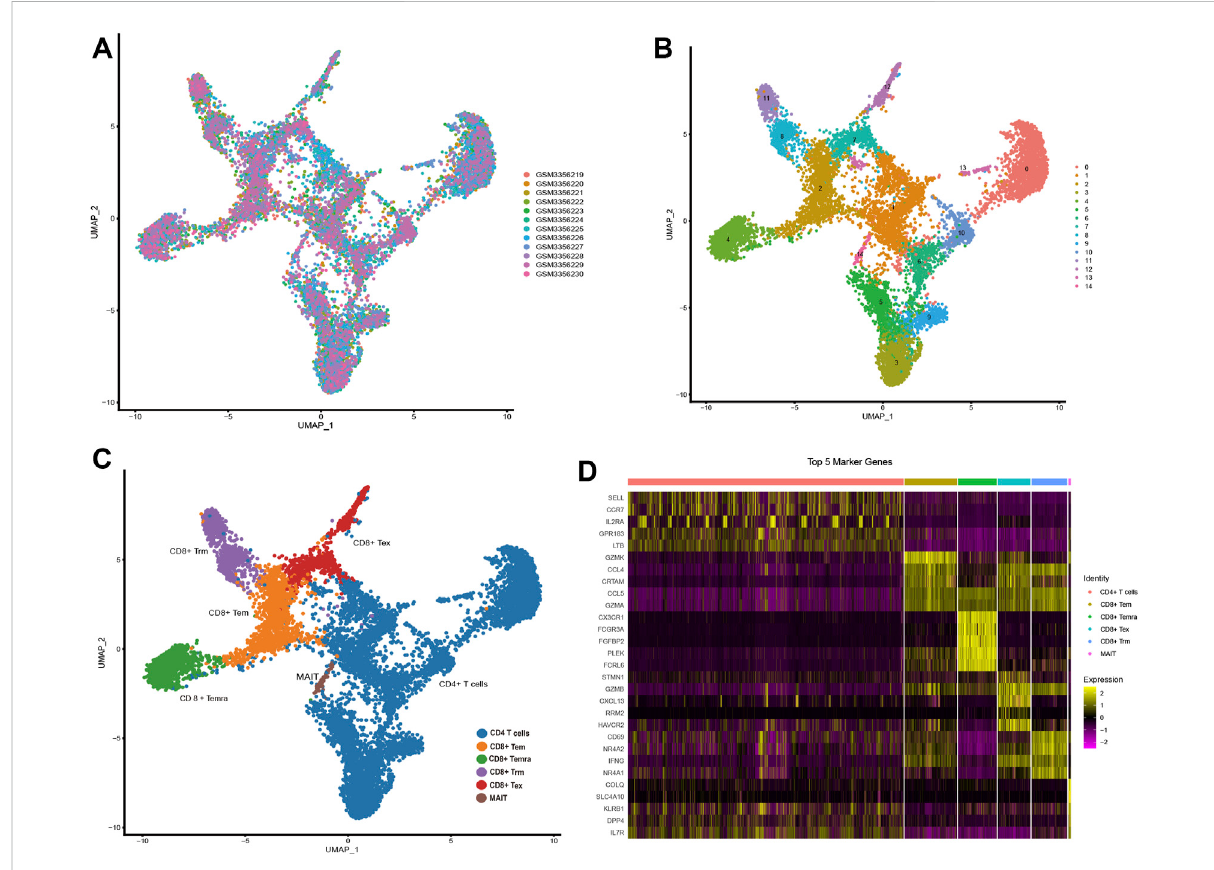
algorithm (Figure 2C), the optimal clustering number was